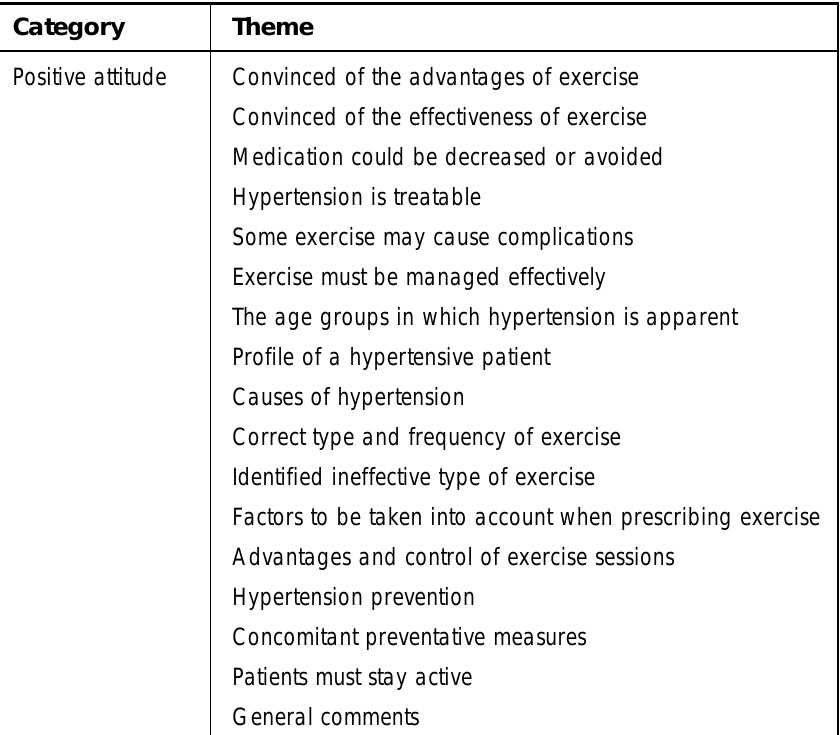
Table 2: Themes identified in the positive attitude category towards exercise as a treatment method for hypertensive